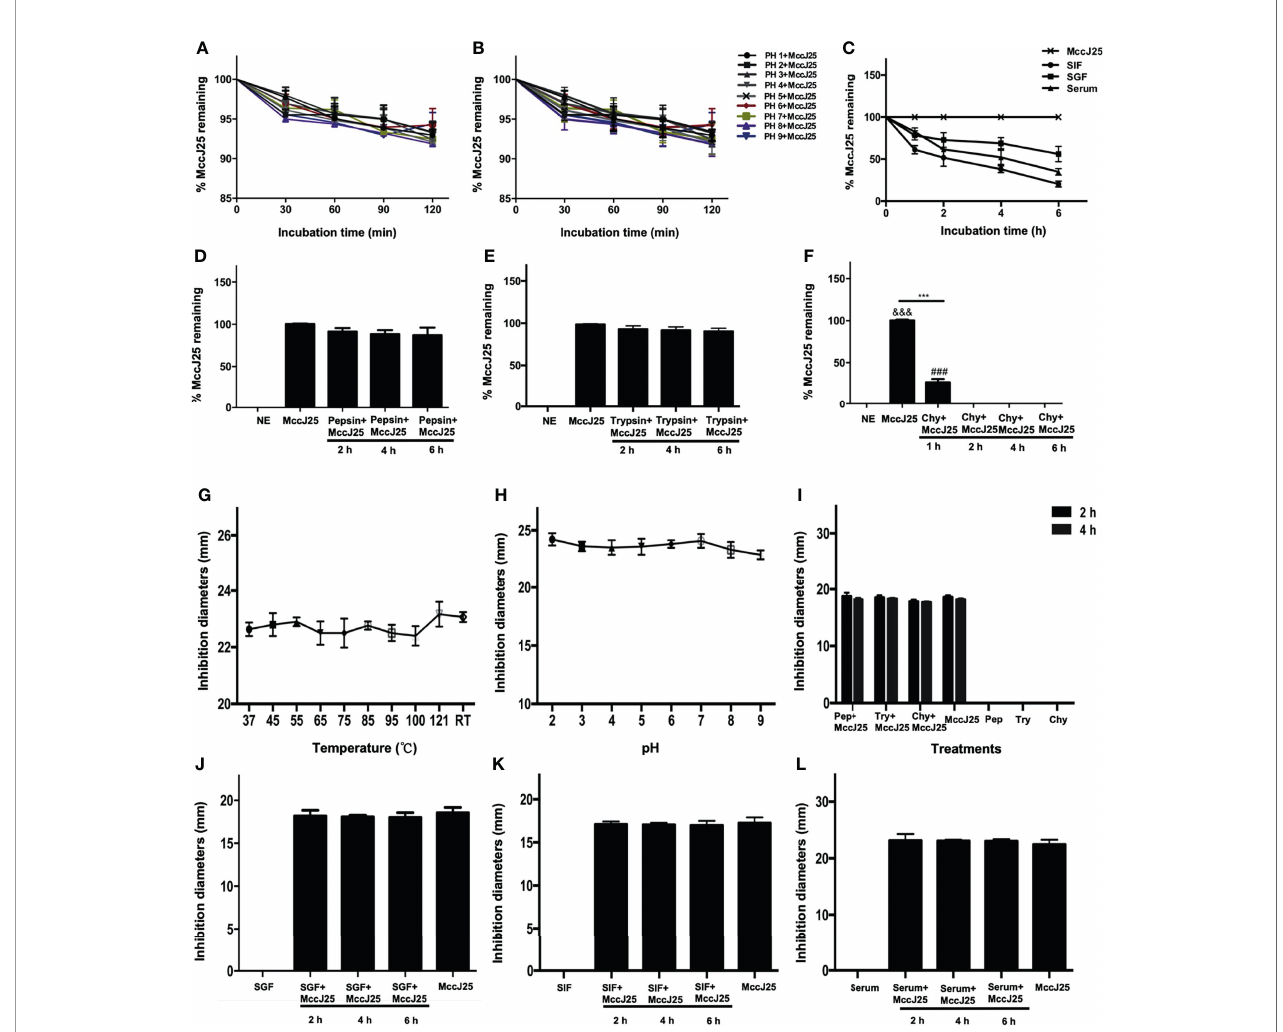
FIGURE 3 | Stability and activity of MccJ25 in different conditions and biological fl uids. Various concentration of MccJ25 was incubated with different temperatures (A) , pH values (B) , (C) SIF, SGF, and serum. Proteases (D-F) for different indicated times. Afterwards, the amount of the remaining MccJ25 was determined by RP- HPLC. All data in this paper are given as the mean ± standard error of mean (n = 6). *** P ≤ 0.001 indicates MccJ25 compared to chymotrypsin plus MccJ25 (1 h); &&& P ≤ 0.001 indicates MccJ25 compared to chymotrypsin plus MccJ25 (2, 4, and 6 h, respectively); ### P ≤ 0.001 means chymotrypsin plus MccJ25 (1 h) compared to chymotrypsin plus MccJ25 (2, 4, and 6 h, respectively). NE: negative control; Chy: chymotrypsin. (G-L) MccJ25 maintains its strong antibacterial activity under different conditions. Effects of temperature (G) , RT: room temperature, pH values (H) , proteases (I) , SGF (J) , SIF (K) , and serum (L) on the inhibition of E coli K88 by MccJ25. The zone of inhibition is often used to clarify the antimicrobial activity of MccJ25. The results showed that no signi fi cant differences were demonstrated between the treatment groups ( P > 0.05). Chy refers to chymotrypsin. Data are presented as the mean of 6 biological replicates ± standard error of mean